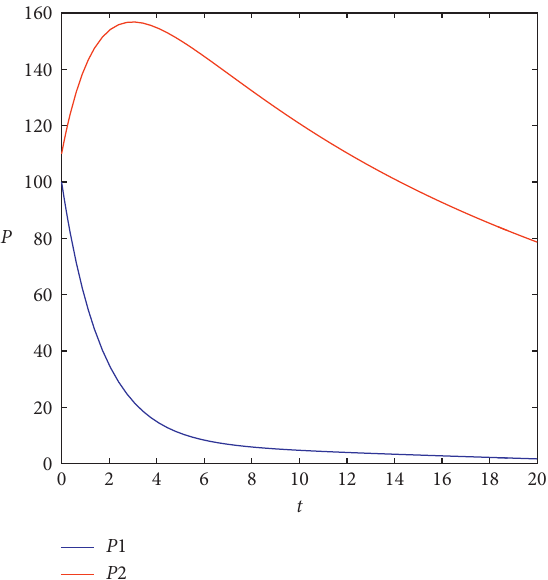
Figure 6: Pollution stock of the upstream P